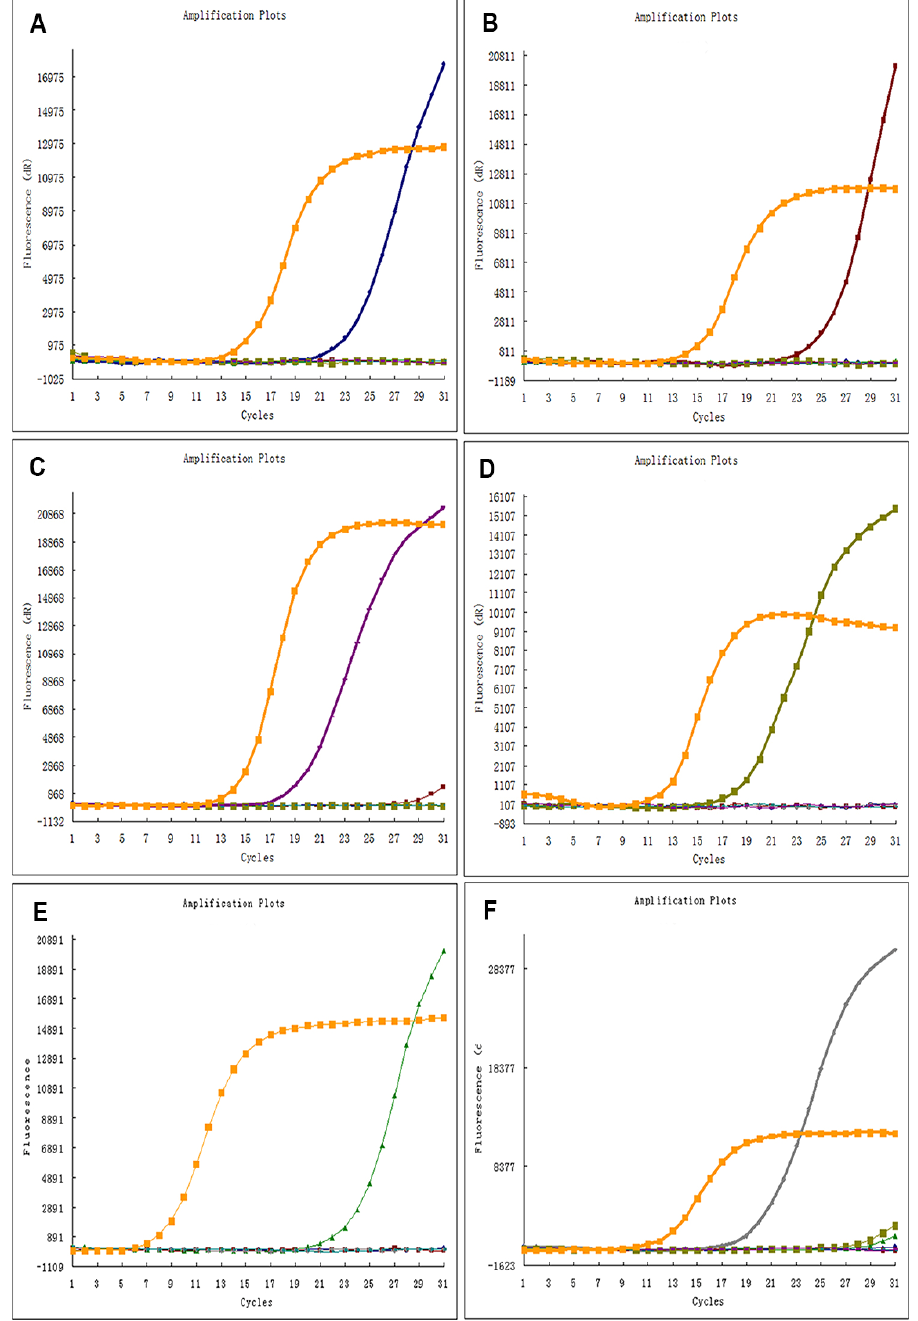
Figure 1. Representative results for ADx-ARMS of EGFR mutation testing. ( A – F ) demonstrate the typical results of exon 19 deletion mutation, exon 21 L858R point mutation, exon 21 L861R point mutation, exon 18 G719X point mutation, exon 20 T790M point mutation, exon 20 insertion mutation, respectively. The orange lines are the internal control signal (HEX), the blue lines, red lines, purple lines, dark green lines, light green lines and the gray lines are mutant signal (FAM), representing 19-del, L858R, G719X, T790M and 20-ins,